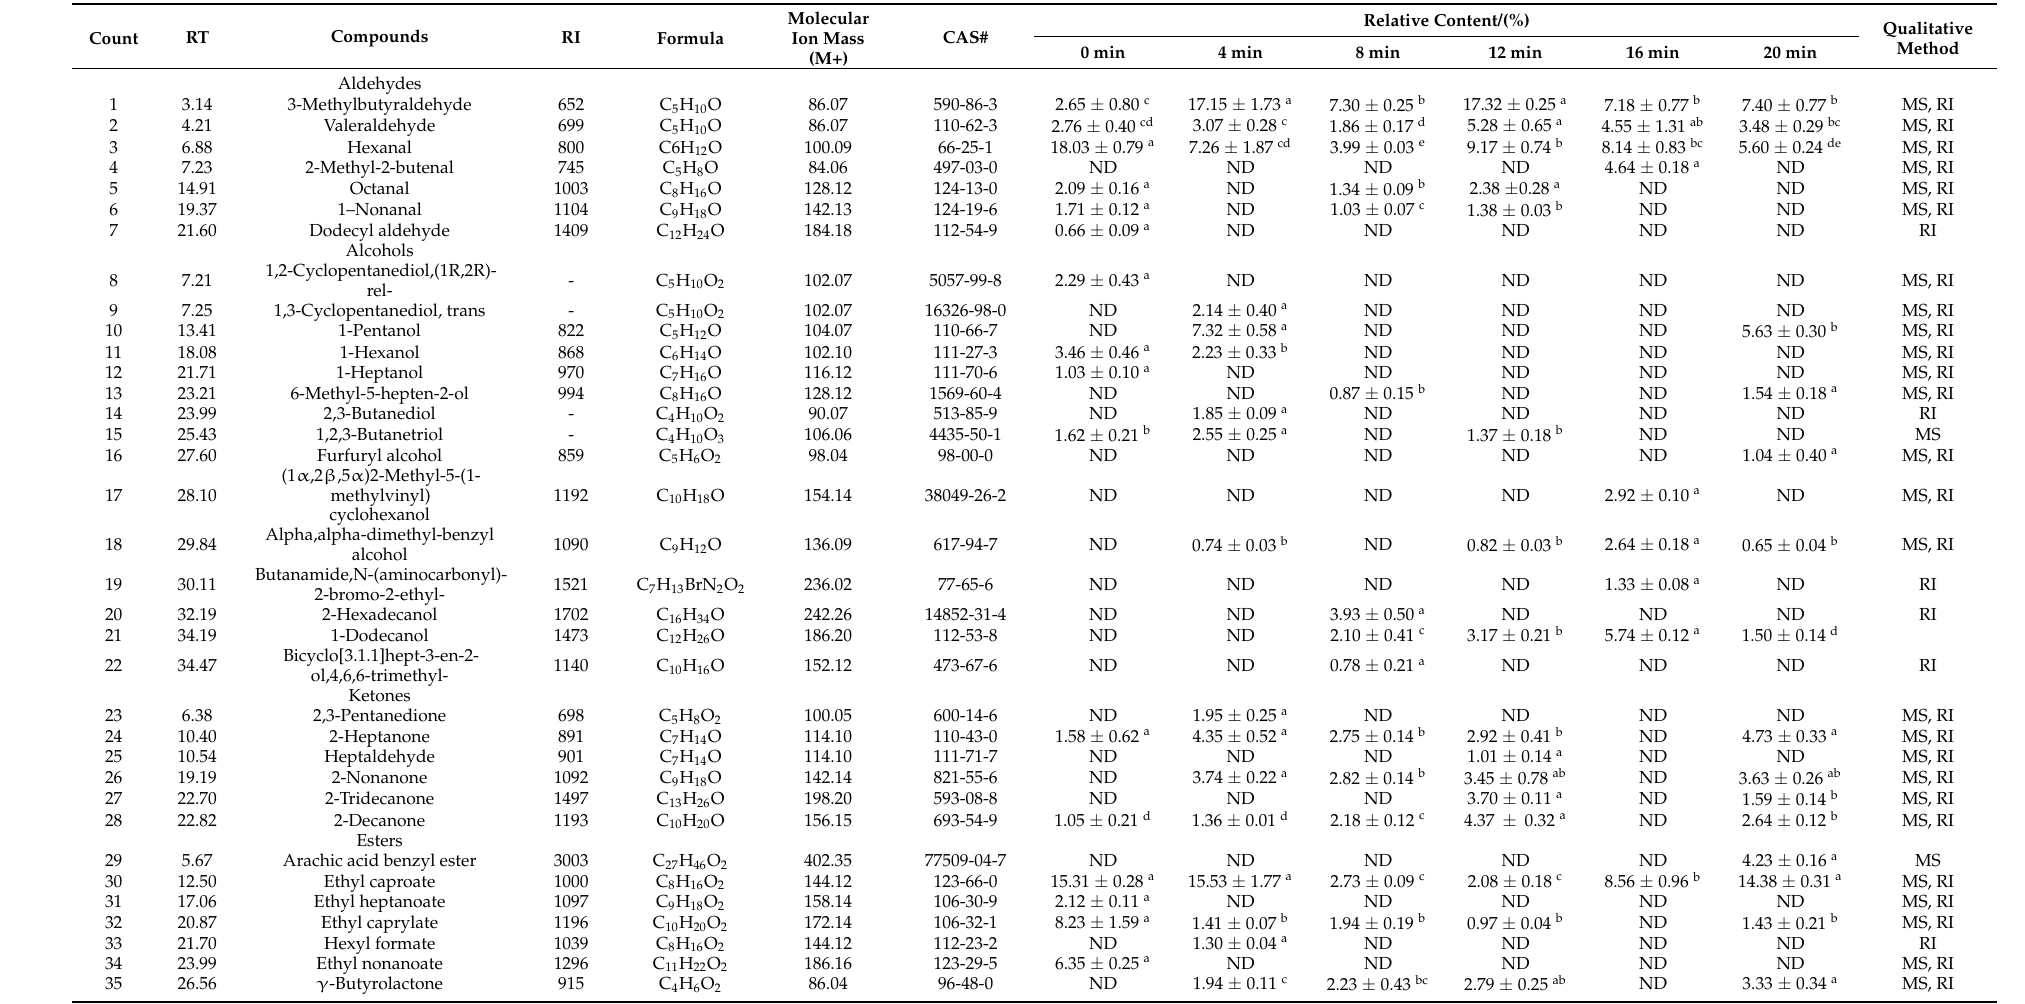
Table 1. VOCs in defatted tiger nut